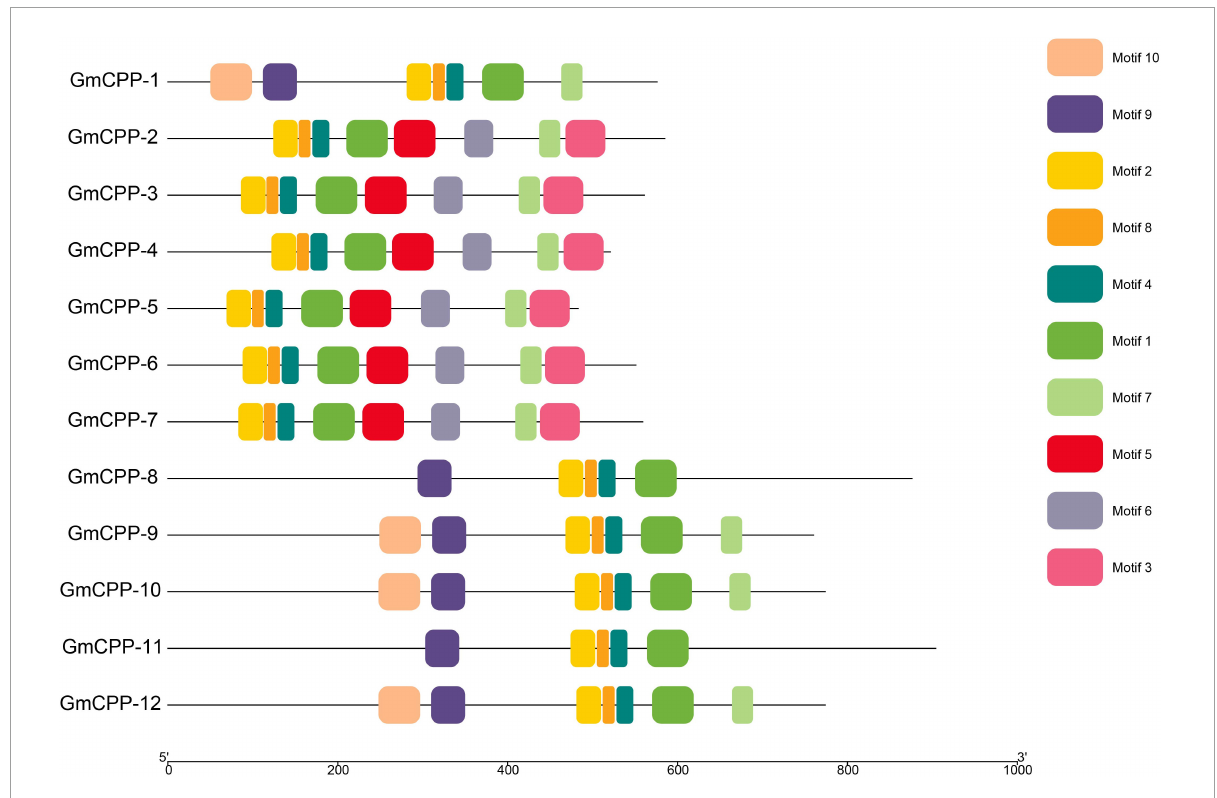
FIGURE4 Motifs in all GmCPP genes. Distribution of conserved motifs in GmCPP are presented in different